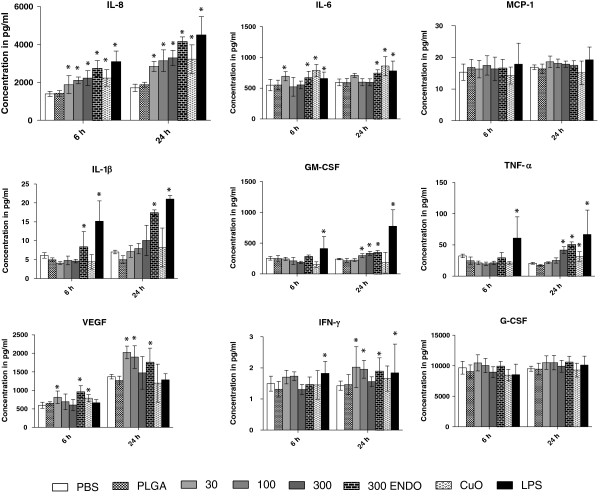
Levels of various cytokines at 6 and 24 h after nanoparticle treatment in primary nasal epithelial cells. The concentrations of various cytokines measured in cell culture supernatant after nanoparticle treatment at different time points. All values are in picograms and represented as mean± SE.